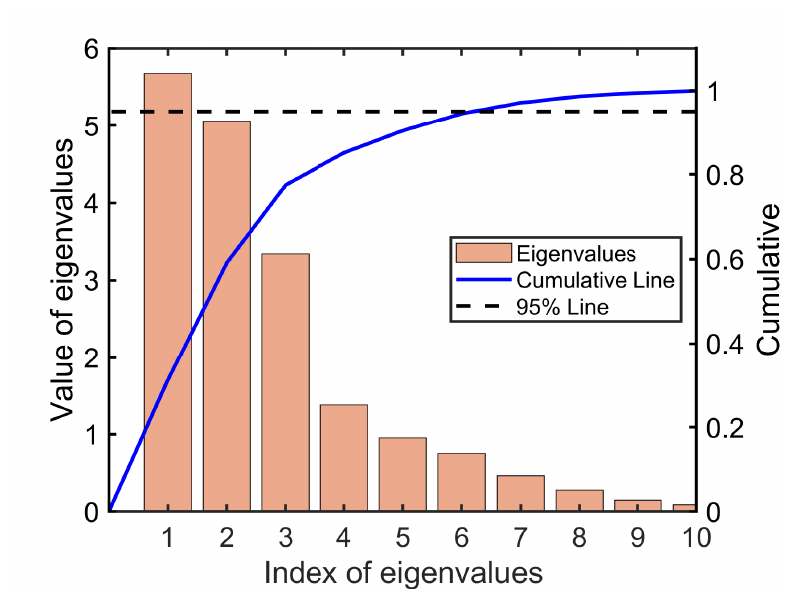
Figure 4. Demonstration of the eigenvalues from the modes of variation and their cumulative